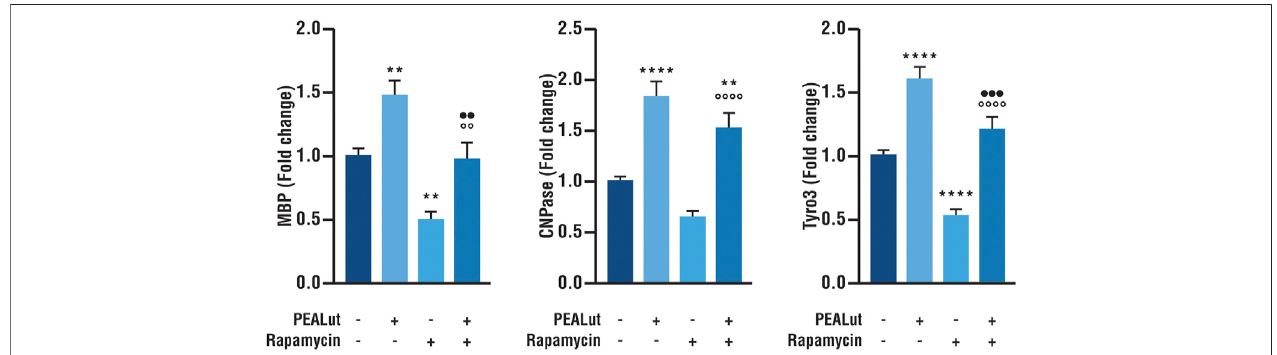
FIGURE 2 | PEALut effects on rapamycin-treated OPCs at DIV 8. Cultures of OPCs were treated with 10 μ M PEALut at DIV 2 and processed at DIV 8 for real-time PCR.Rapamycinwasadded30 minbeforePEALut.Dataareexpressedasmean ± SEM.Datawereanalyzedwithone-wayANOVAfollowedby posthoc Holm-Sidak ’ s multiple comparisons test. Data were obtained from fi ve separated experiments (15 values). MBP: ** p < 0.005 vs vehicle; °° p < 0.005 vs rapamycin; PEALut.CNPase:** p < 0.01 vs vehicle;**** p < 0.0001 vs vehicle; °°°° p < 0.0001 vs rapamycin;Tyro3:**** p < 0.0001 vs vehicle; °°°° p < 0.0001 vs rapamycin; 0.001 vs